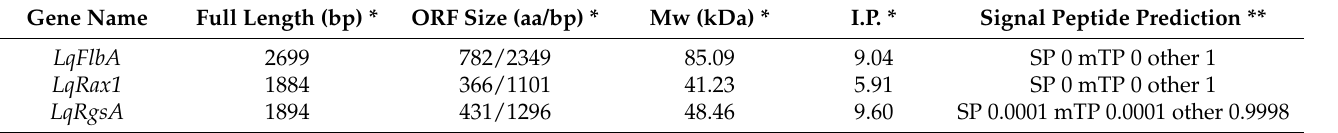
Table 4. Physicochemical properties and cellular localization of RGSs of L. qinlingensis